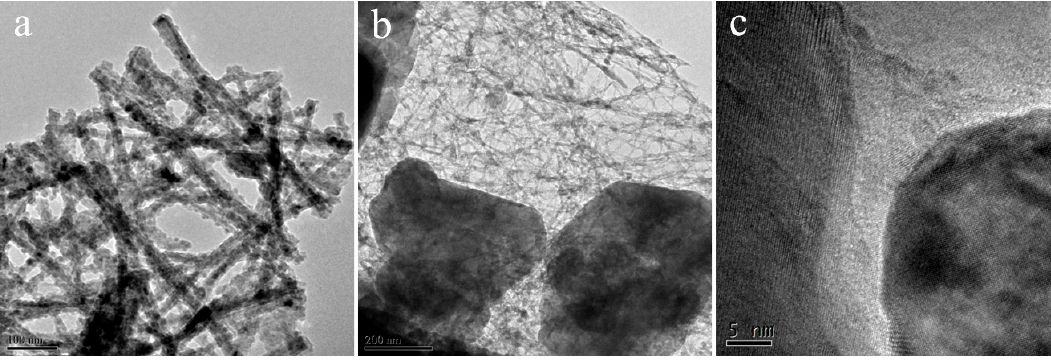
Figure 4. TEM images (a,b) and high resolution image (c) of MnO-4.